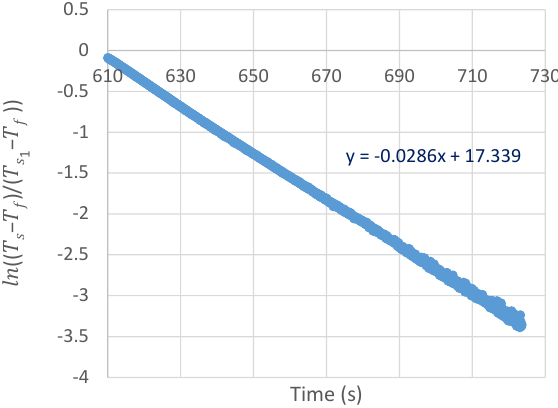
Fig. 3 Temporal curve representing the linearization of the transient state during the heating phase step with a propeller velocity of 1000 rpm and with hot and cold temperatures of 250 °C and of 31°C